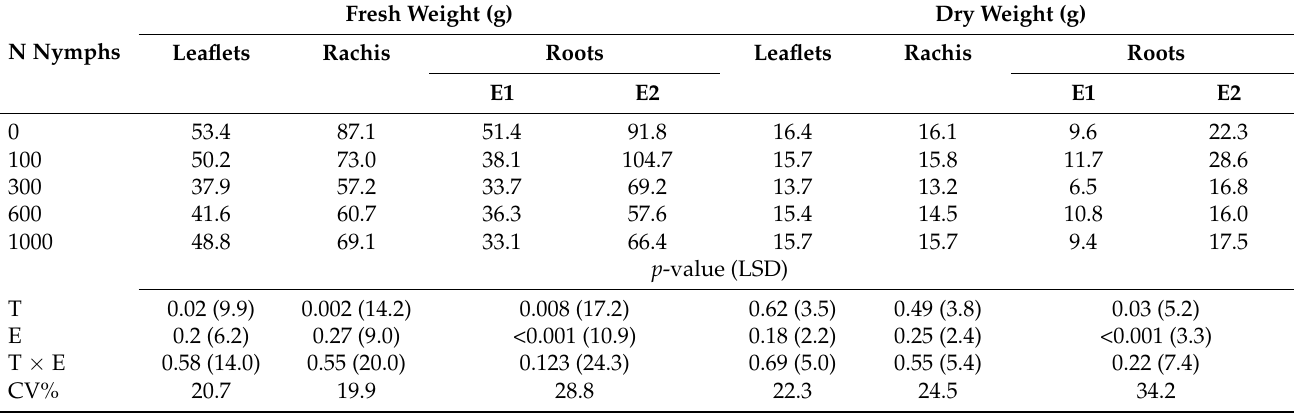
Table 1. Fresh weight and dry weight of the rachis, leaflets, and roots of date palms. ANOVA and the least significant difference at p < 0.05 were used to compare means between treatments. T = Treatment, E =